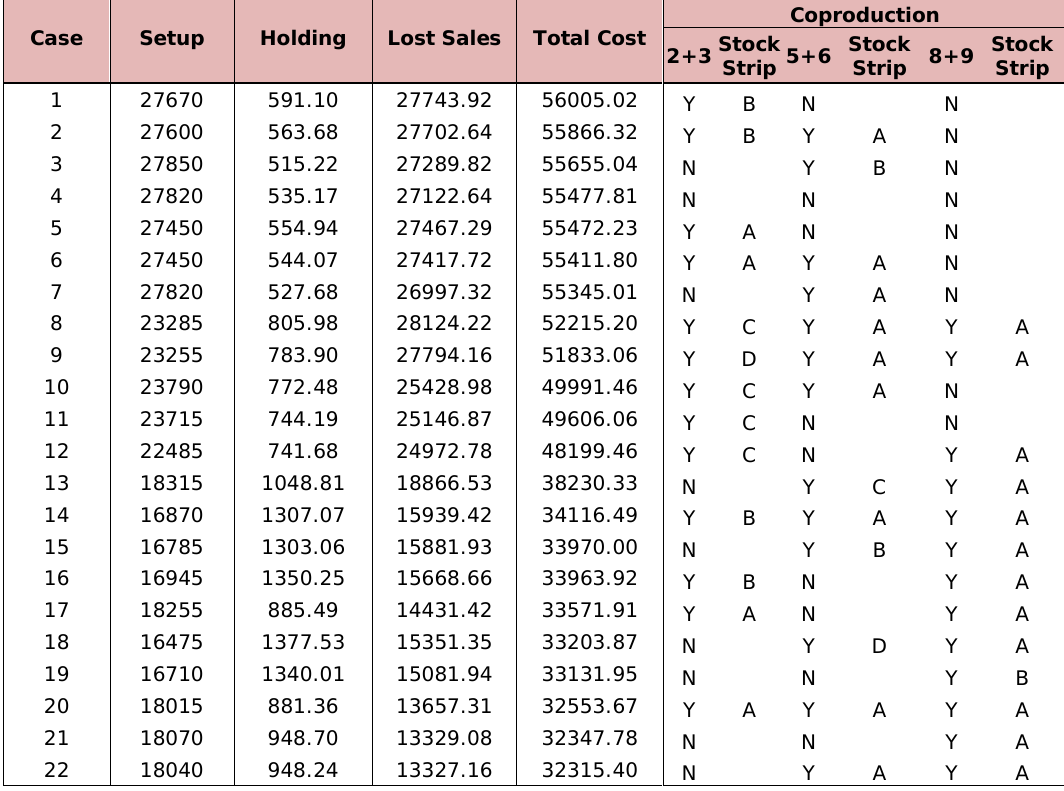
Table 5. “Costs for different coproduction cases when applying the modified EMQ